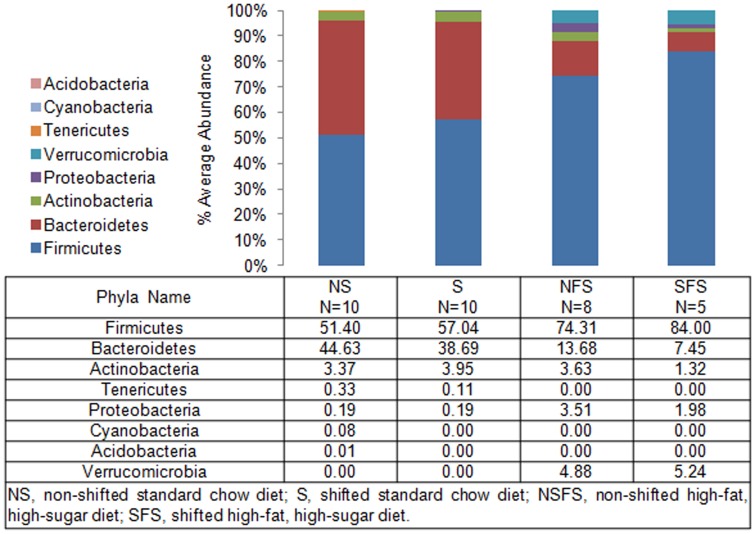
Mouse gut microbial community structure at the phylum level.The bar graph graphically represents the average relative abundance of classified bacteria SSU rRNA gene amplicons belonging to the most abundant phyla.